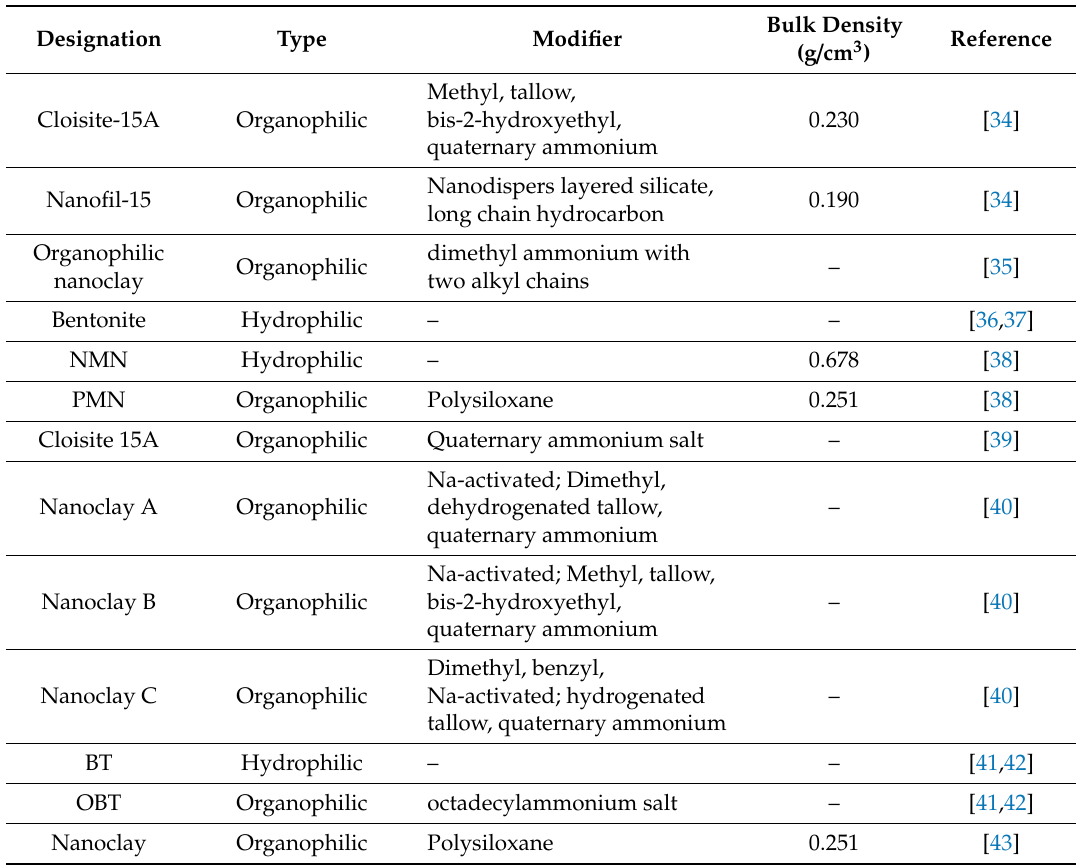
Table 2. Properties of nanoclay used by several authors.